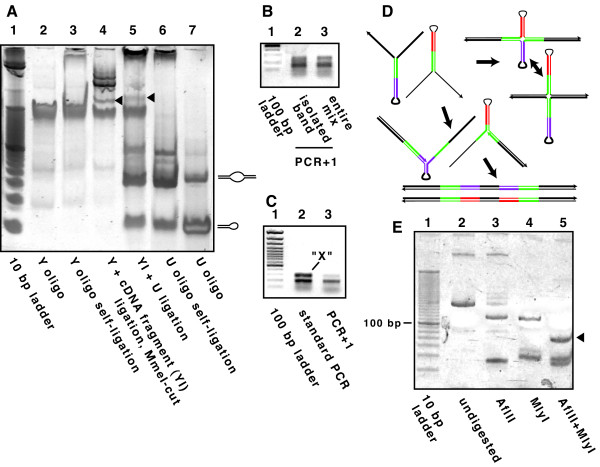
Generation of shRNA constructs using YIU. (A) Intermediate products produced during the YIU procedure. Lanes 2 and 3. The Y oligonucleotide, designed with a single 3' T overhang and therefore unable to self-ligate. Lane 2, without ligase. Lane 3, with ligase. Note that the forked shape of the Y oligonucleotide causes abnormal mobility on PAGE. The ligated and MmeI-digested YI molecules are indicated by an arrowhead in lane 4; the digested YI molecules shift in migration when ligated to the U oligonucleotide (arrowhead, lane 5). Note that the YIU molecules are a minor fraction of the product molecules because the Y and U oligonucleotides were added at a large molar excess over cDNAs and that the ligation was efficient, as almost all of the U oligonucleotides have been converted to dimers. (B) PCR amplification of YIU ligation products. The template used for PCR in lane 2 was the PAGE-purified DNA band corresponding to the one labeled with arrowhead in lane 5 of Panel A. The template for lane 3 was the whole YIU ligation mixture shown in lane 5 of Panel A. The calculated size of YIU double-stranded DNA is 160 bp. (C) Conversion of the X molecule into double-stranded DNA by a "PCR+1" protocol. PCR amplification of YIU with 20 cycles results in an extra band (the X molecule) seen in the 200–300 bp region on agarose gels (lane 2). However, when the PCR products are diluted with fresh PCR reaction mix (1 × buffer, dNTPs, primers and enzyme) and subjected to one additional PCR cycle, the high molecular weight band is lost (lane 3). (D) Scheme of the generation of X molecules. Vent polymerase, through its strand-displacement activity, can open hairpin structures to generate fully double-stranded products. As the PCR progresses, however, YIU double-stranded DNA molecules accumulate and the concentration of primers decreases. When the templates are heat denatured and cooled, two heterogeneous molecules (shown in red or purple) can form an X-shaped (cruciform) heterodimer via the common complementary regions (shown in green). (E) Restriction digestion of double-stranded DNA of YIU. The YIU double-stranded DNA generated by PCR (the "uncut" lane) is digested with AflII or MlyI individually, or in combination to generate suitable inserts for cloning.